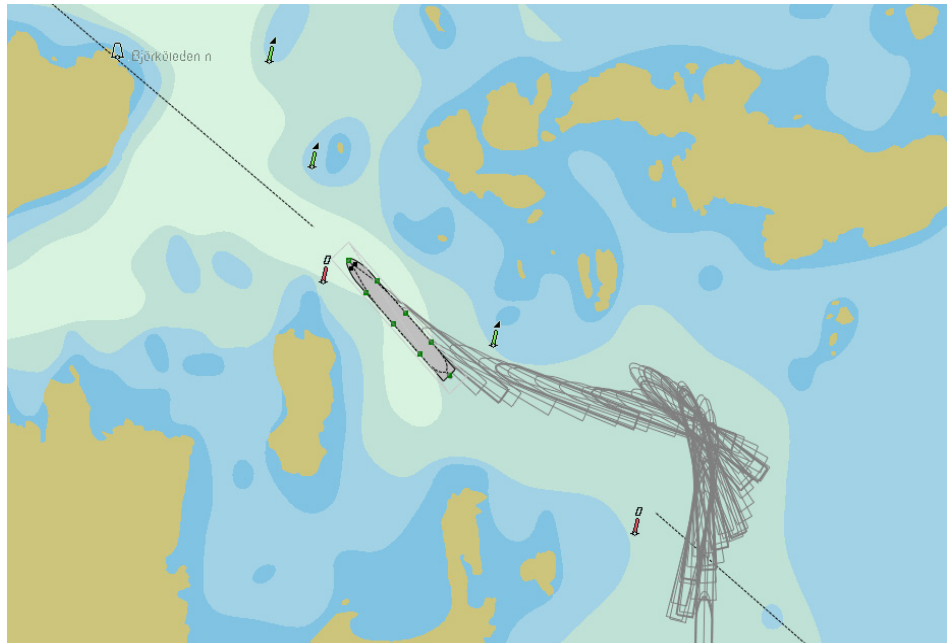
Figure 11. A PANAMAX-type container vessel crossing the navigational channel near Korsakobben Island (entry to Stockholm archipelago), where: buoys on chart are marked in black (own elaboration based on [73]).